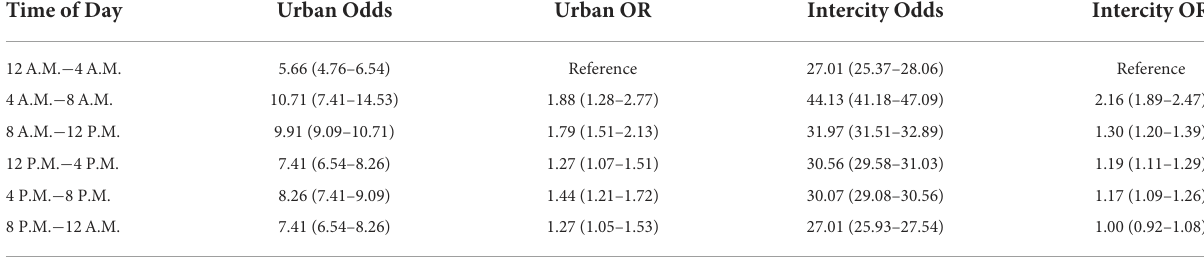
TABLE 2 Probability and odds ratio (OR) of kangaroo driving (KD) for urban and intercity trips, by the 4-h period of the day. Time of Day Urban Odds Urban OR Intercity Odds